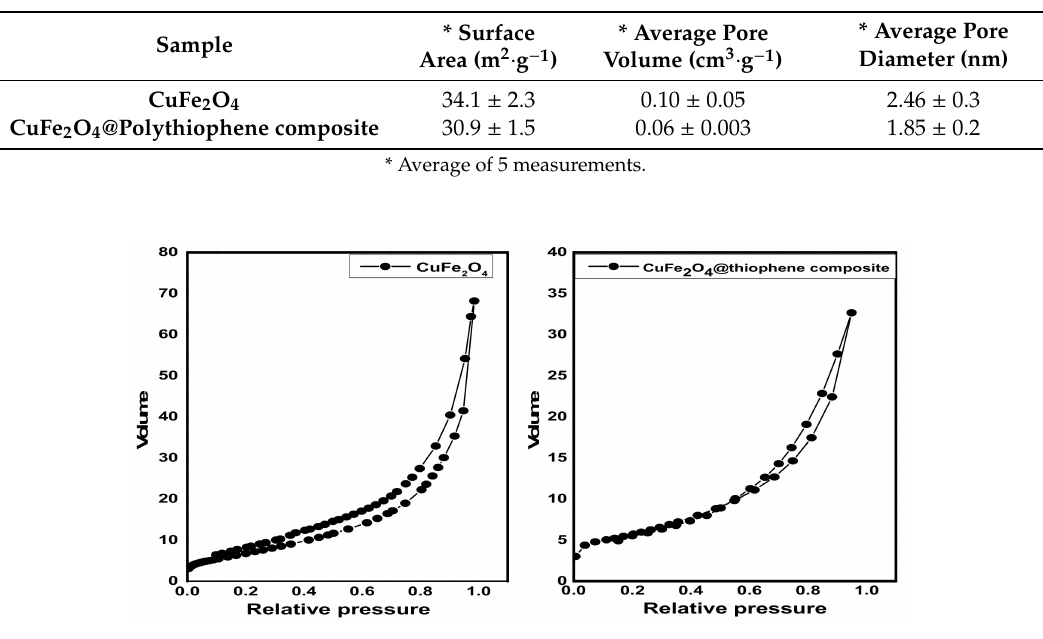
Figure 4. N 2 adsorption–desorption isotherms of CuFe 2 O 4 and CuFe 2 O 4 @Polythiophene